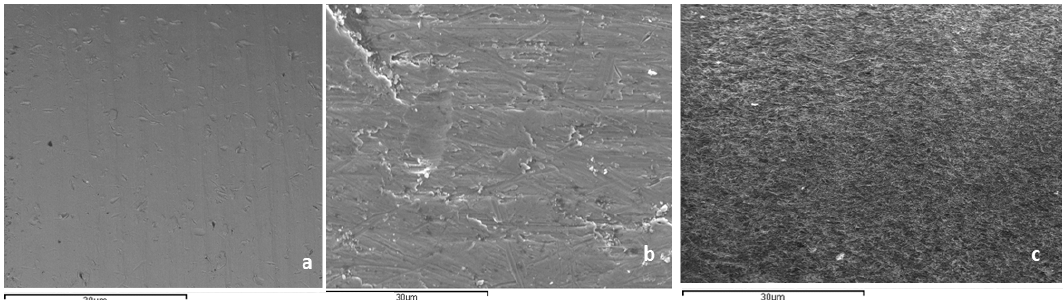
Figure 4. Surfaces with different chemical treatments. ( a ). Control. ( b ). Treated with hypochlorous acid. ( c ). Treated with hypochlorous acid and hydrogen peroxide.